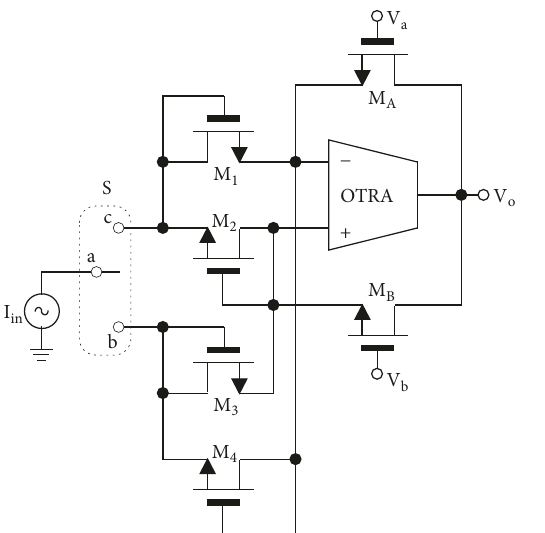
Figure 4: The proposed full MOSFET-based full-phase operation transresistance-mode precision full-wave rectifier.